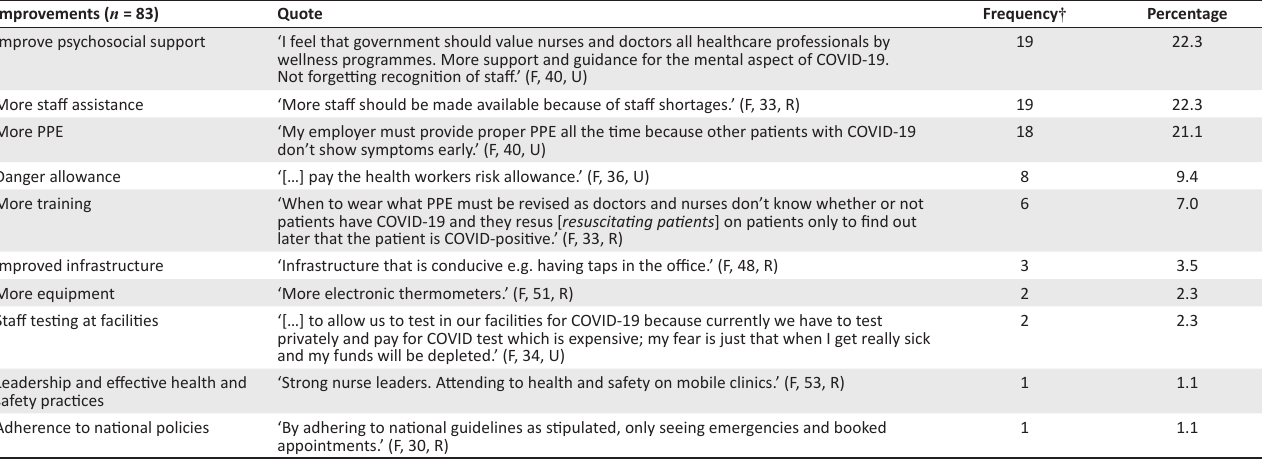
TABLE 7: Suggestions for improvement.